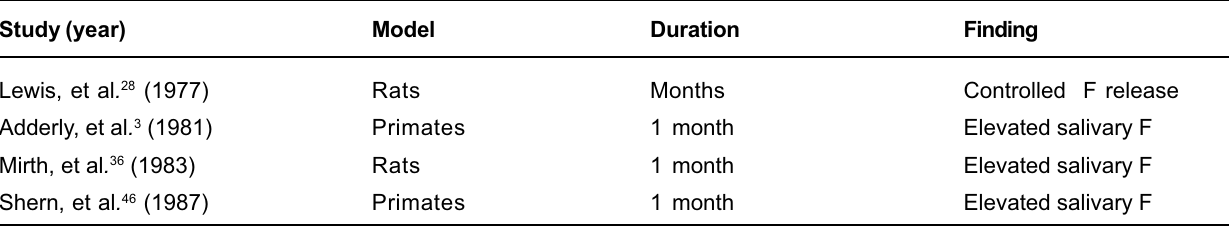
From: Al-Ibrahim NI. Unilateral versus bilateral placement of slow-release fluoride glass device. II. In vitro assessment of slow-release fluoride glass device [thesis]. Leeds(UK): University of Leeds;